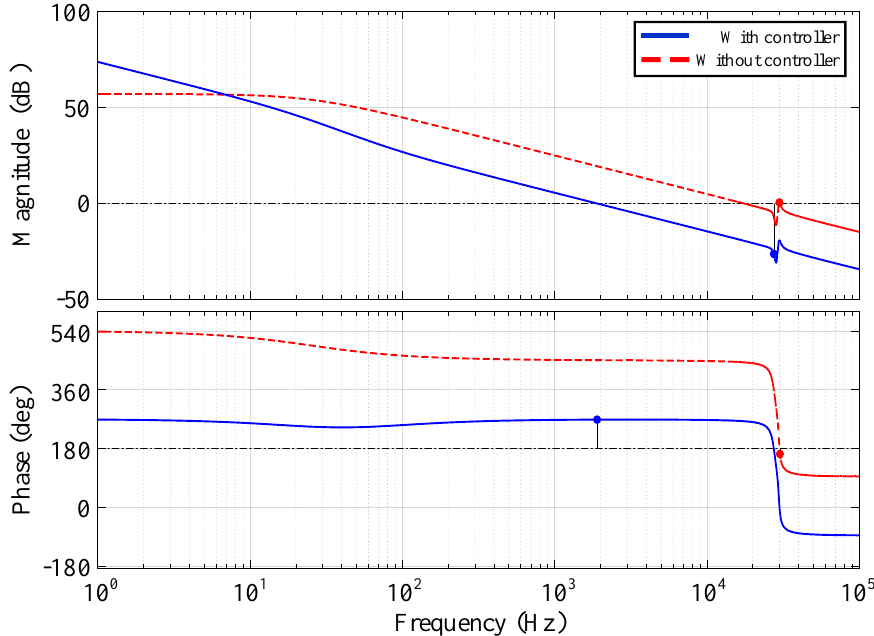
Figure 10. Gain and phase plots of loop gain with and without controller under worst case condition.